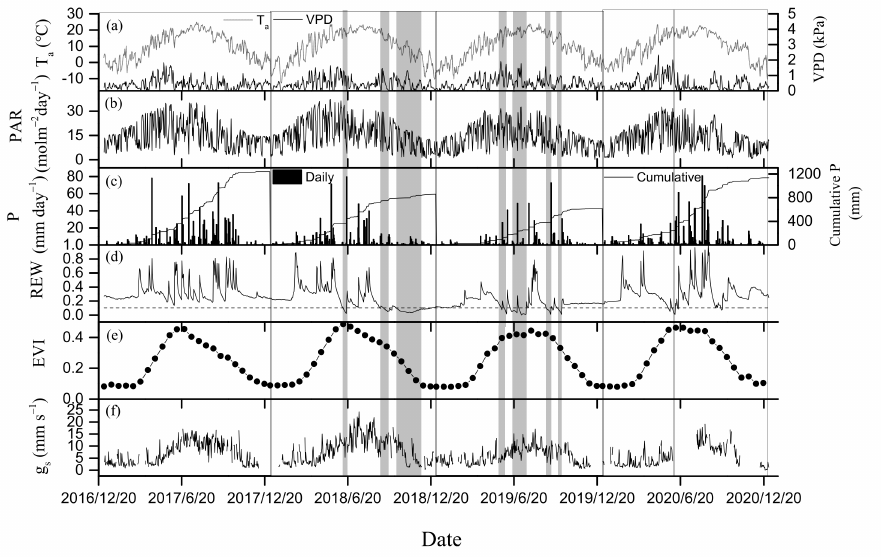
Figure 3. Temporal dynamics of ( a ) daily mean air temperature (T a ) and water vapor pressure deficit (VPD) at 22 m, ( b ) daily cumulative photosynthetically active radiation (PAR, molm − 2 day − 1 ), ( c ) daily and cumulative precipitation (P), ( d ) relative extractable water content (REW), ( e ) 16-day composited MODIS EVI, ( f ) surface conductance (g s ). Gray-shaded bands in plot indicate dryness stage. Table 1. Annual mean air temperature (T a , ◦ C), water vapor pressure deficit (VPD, kPa),